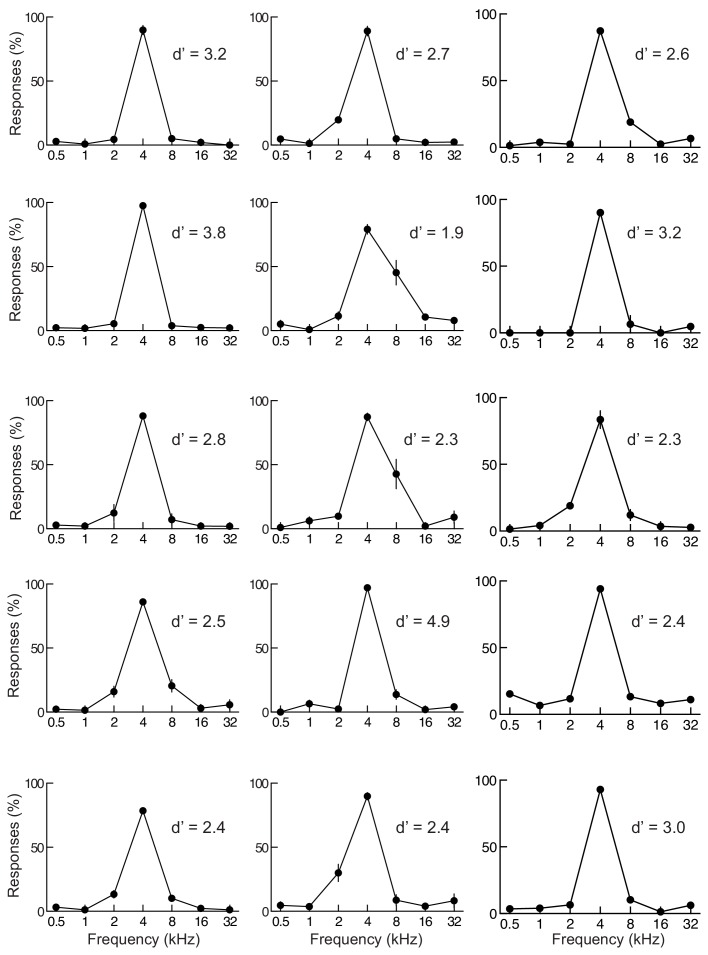
Individual response curves from 15 animals included in this study.Each panel shows data from a different animal including behavioral d' for distinguishing target from non-target tones. We used a criteria of d'≥1 for inclusion in this study. Response curves here are for an average of three to four sessions. Error bars represent S.E.M.